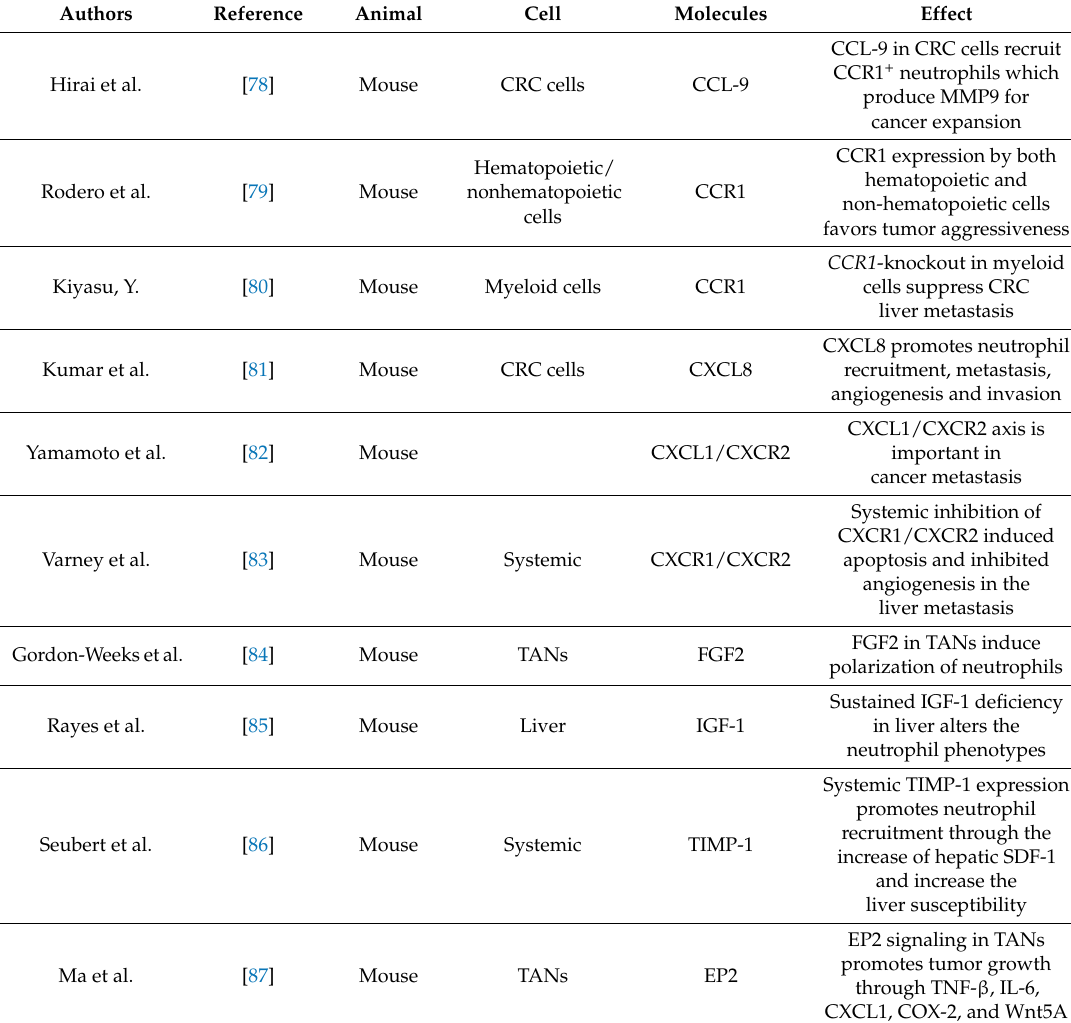
Table 1. TANs in animal models for CRC